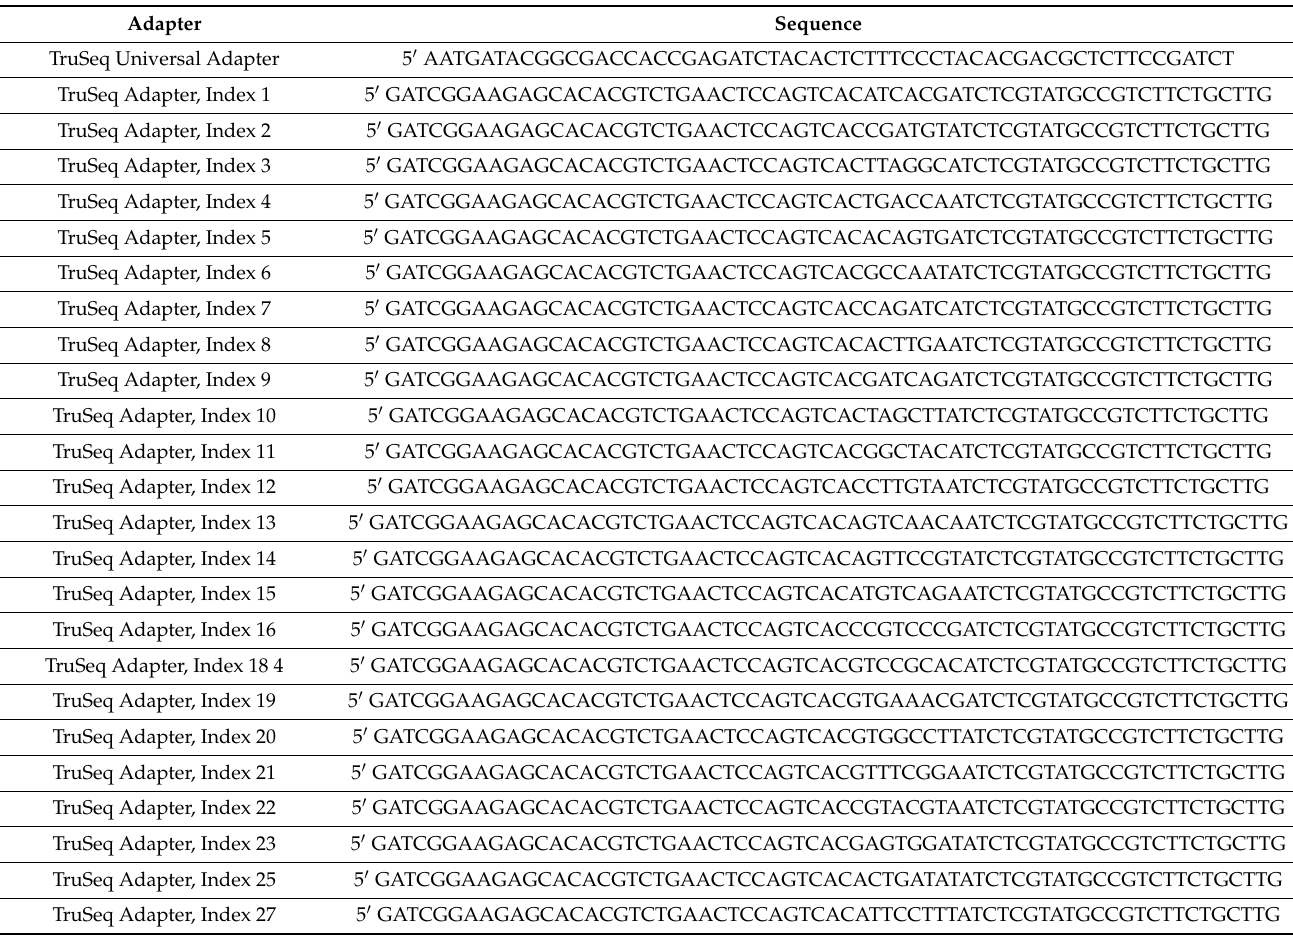
Table 1. Oligonucleotide sequences for TruSeq™ RNA and DNA Sample Prep Kits